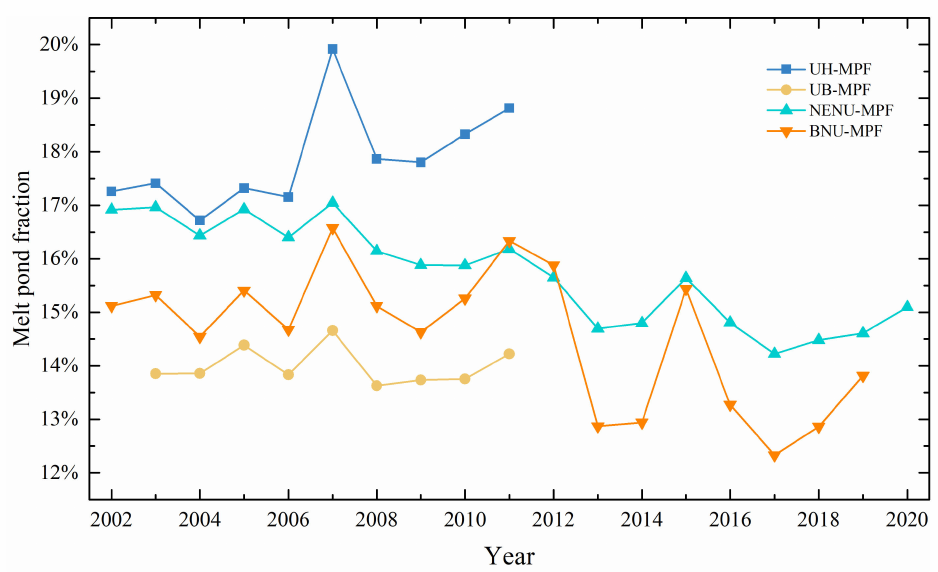
Figure 16. The annual-mean MPF derived from the different datasets (UH-MPF, UB-MPF, NENU- MPF, and BNU-MPF datasets from May to September). Only the pixels with valid MPF values were